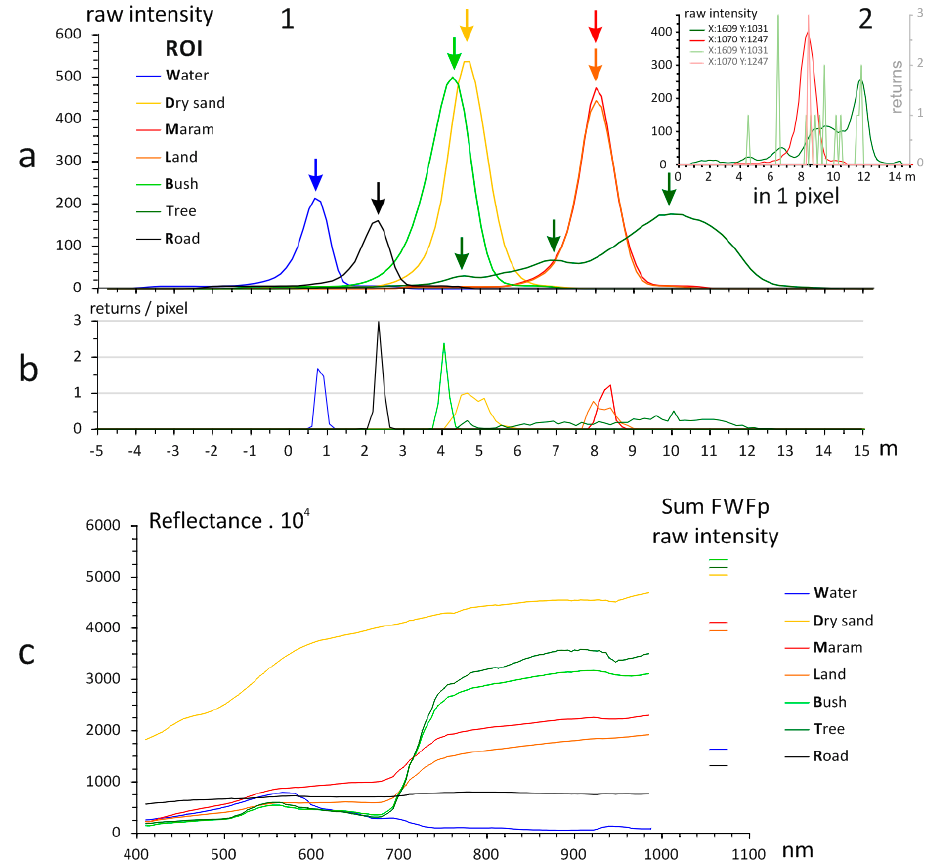
Figure 5. Comparison between echoes, FWFp and hyperspectral spectra. ( a ) 1: FWFp of seven regions of interest (ROI) located in Figure 1d,e; 2: FWFp and echoes of 2 pixels of sand and tree; ( b ) distribution of echoes in each ROI; and ( c ) hyperspectral reflectance of the same ROI and sum of FWFp intensity at 1064 nm.